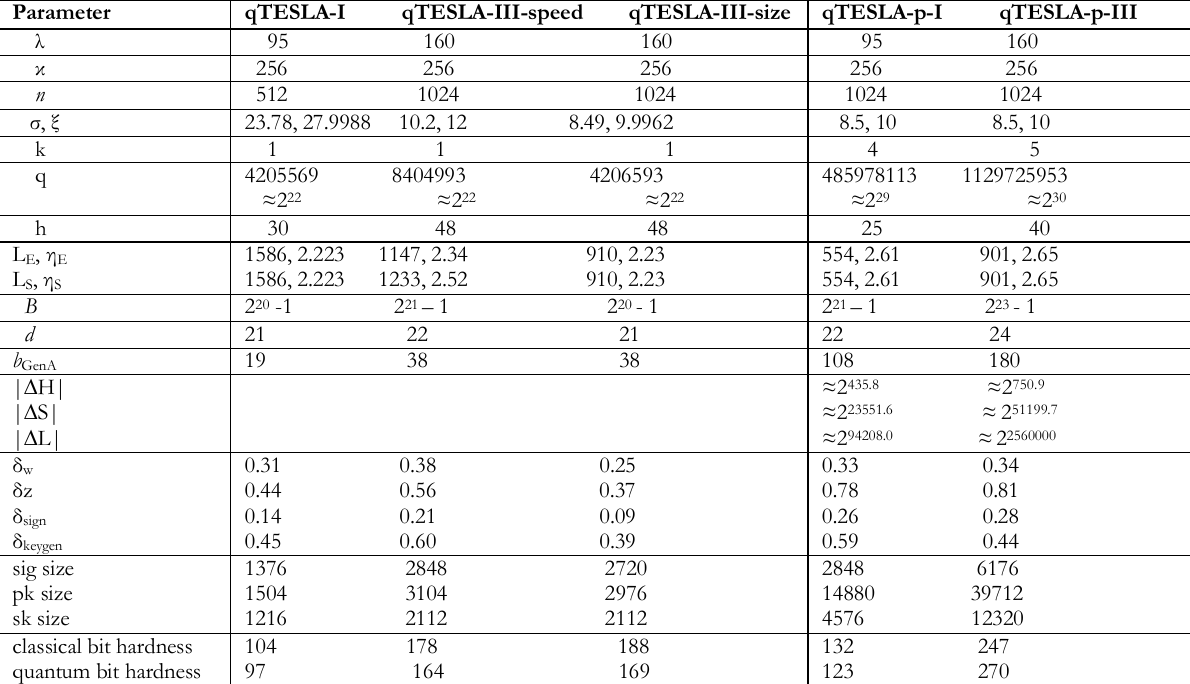
Table 5: Parameters for each of the proposed heuristic and provably-secure parameter sets with q h = 2 128 and q s = 2 64 ; M = 0 . 3 [4]